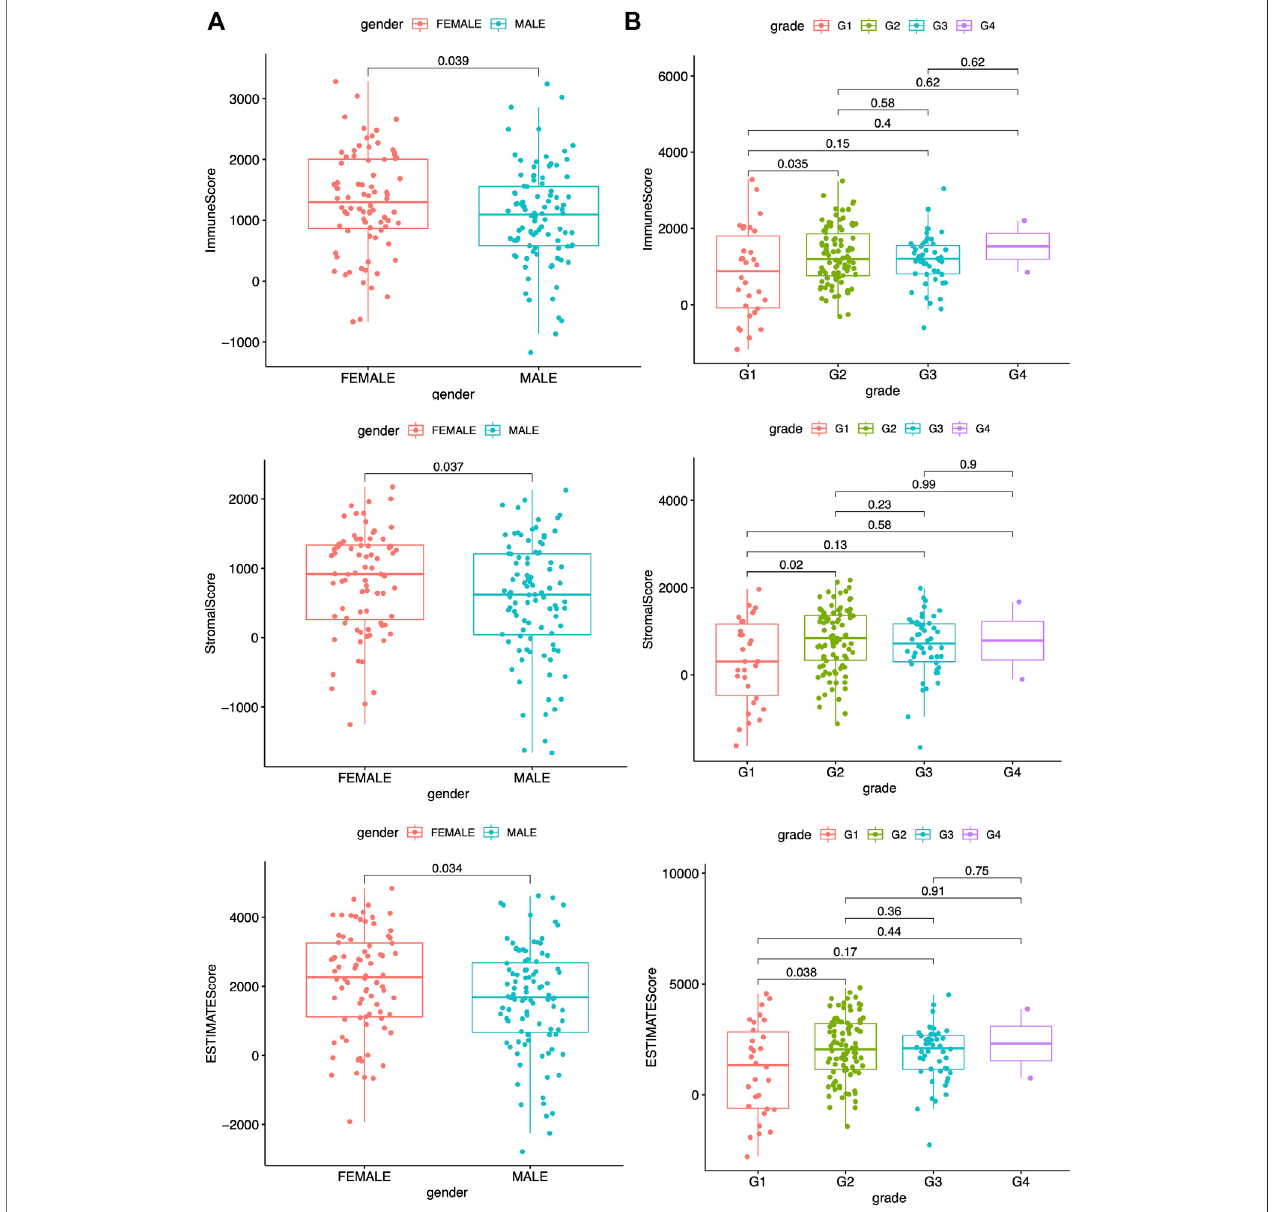
FIGURE 2 | Correlation between scores and clinicopathological characteristics. (A) Correlation analysis of scores and gender. (B) Correlation analysis of scores and grade. All statistical analyses were carried out by Kruskal-Wallis rank-sum